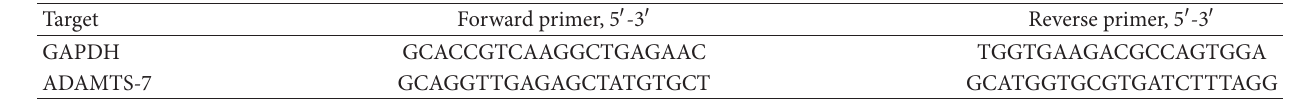
Table 2: Real-time PCR